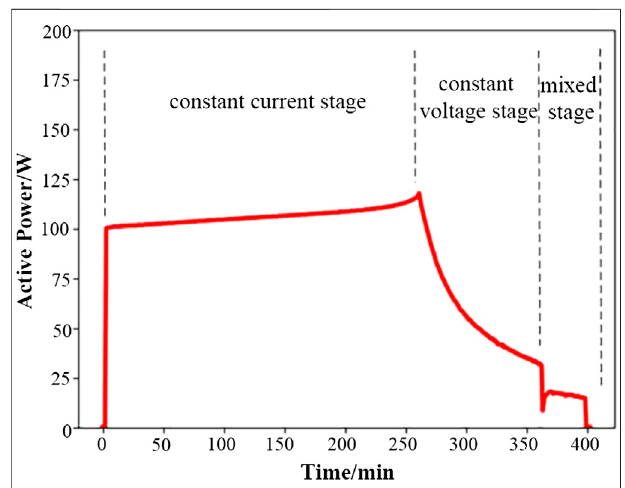
FIGURE 3 | Ratios of harmonic content during the electric bicycle charging. FIGURE 4 | Active power curve in three charging